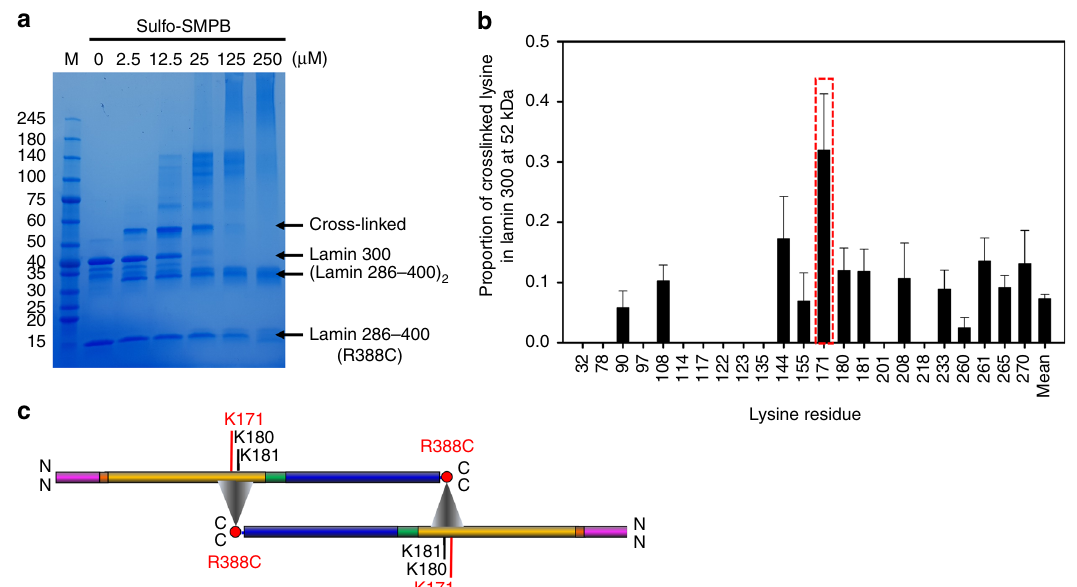
Fig. 5 The eA22 interaction mapping by MS/MS analysis with cross-linked proteins. a The chemical cross-linking assay with the lamin 300 fragment and lamin 286 – 400 R388C mutant in SDS-PAGE. Protein bands of the lamin 300 fragment and the cross-linked sample are labelled. To block the unreacted chemical cross-linker, excess cysteine was added. The major bands of ‘ cross-linked ’ (52 kDa), lamin 300 (38 kDa), dimerized lamin 286 – 400 R388C [(lamin 286 – 400) 2 ; 30 kDa], and lamin 286 – 400 R388C (14 kDa) were excised and subjected to the subsequent MS/MS analysis (Supplementary Data 1). b Proportion ( ^ p ) of the Cys388-bound lysine residues at each position was determined by dividing the number of Cys388-bound lysine residues by the total number of observed lysine residues in the pooled data of cross-linked bands. Position of the most probable Lys171 to be cross-linked to Cys388 is shown in a red box in the plot. The error bars indicate each standard error of proportion, which were calculated by Supplementary Table 2. c Schematic representation of the central rod domains of two coiled-coil dimers in the colour code of Fig. 1a, displaying the eA22 interaction based on the results of the MS/MS analysis. Triangles indicate that Arg388 (or Cys388) of coil 2 is around Lys171 (or its neighboring Lys180 or Lys181) of coil 1b in lamin 300